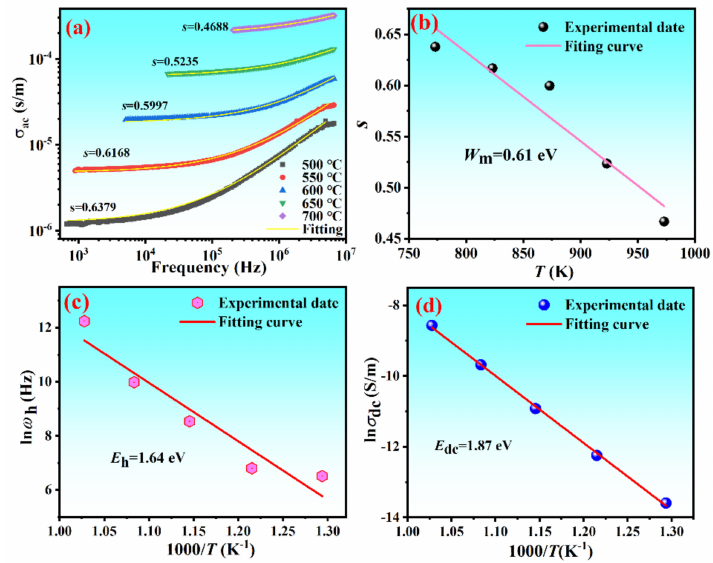
Figure 5. Fitting for the temperature and frequency dependence of conduction parameters of the composition with x =